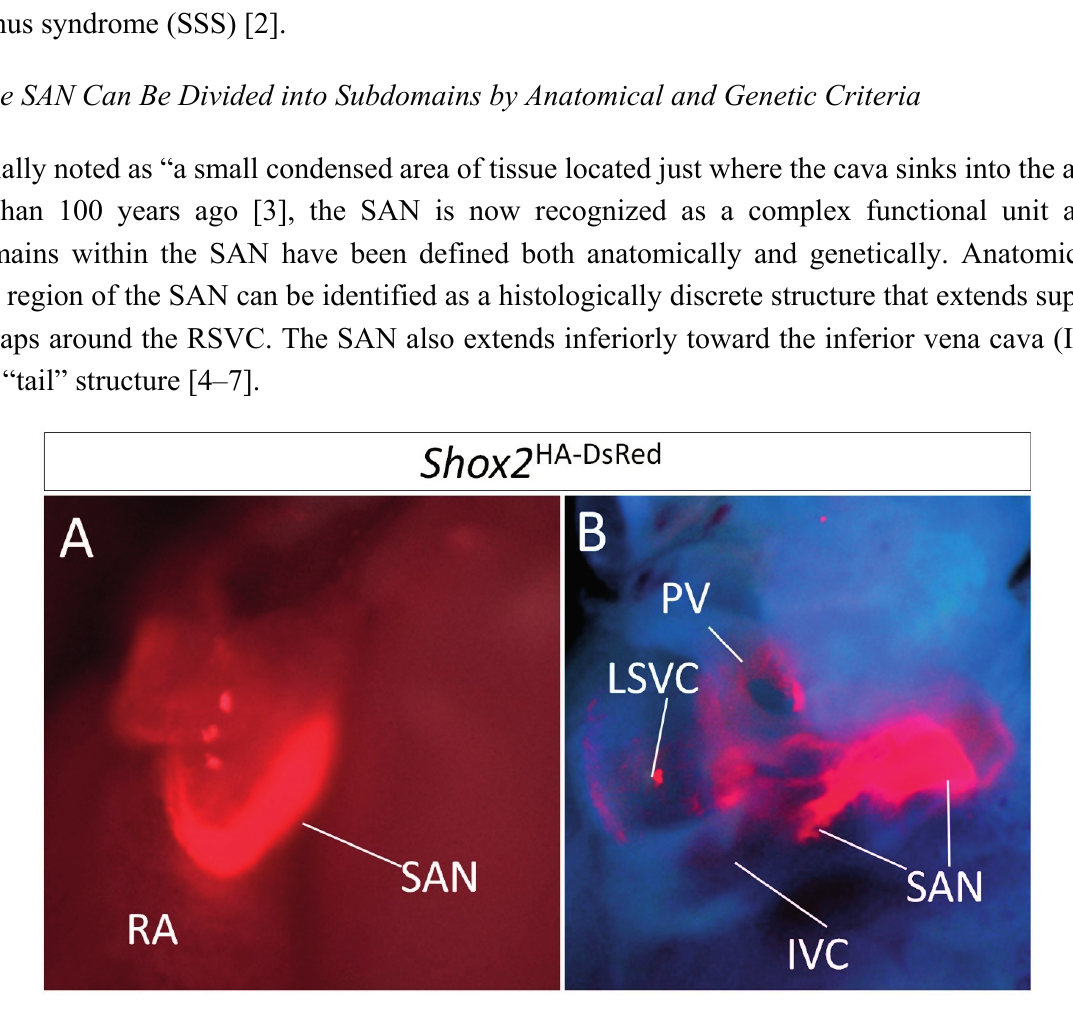
Figure 1. Visualization of Shox2 expression in the SAN by Shox2 HA-DsRed allele. ( A ) Frontal view of Shox2 expression in the SAN of a mouse carrying a Shox2 HA-DsRed allele at Postnatal Day 8 (P8), as revealed by DsRed expression. ( B ) Dorsal view of Shox2 expression in the same mouse. PV, pulmonary vein; RA, right atrium; IVC, inferior vena cava; SAN, Sinoatrial node; LSVC, left superior vena